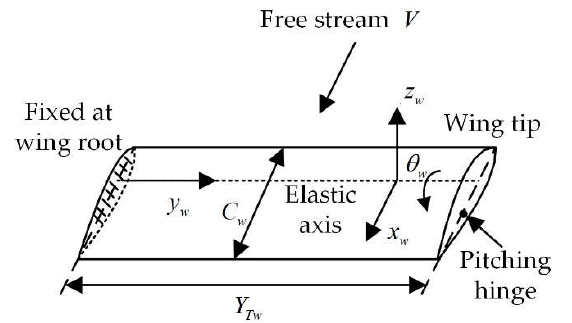
Figure 2. Schematic of the flexible wing.